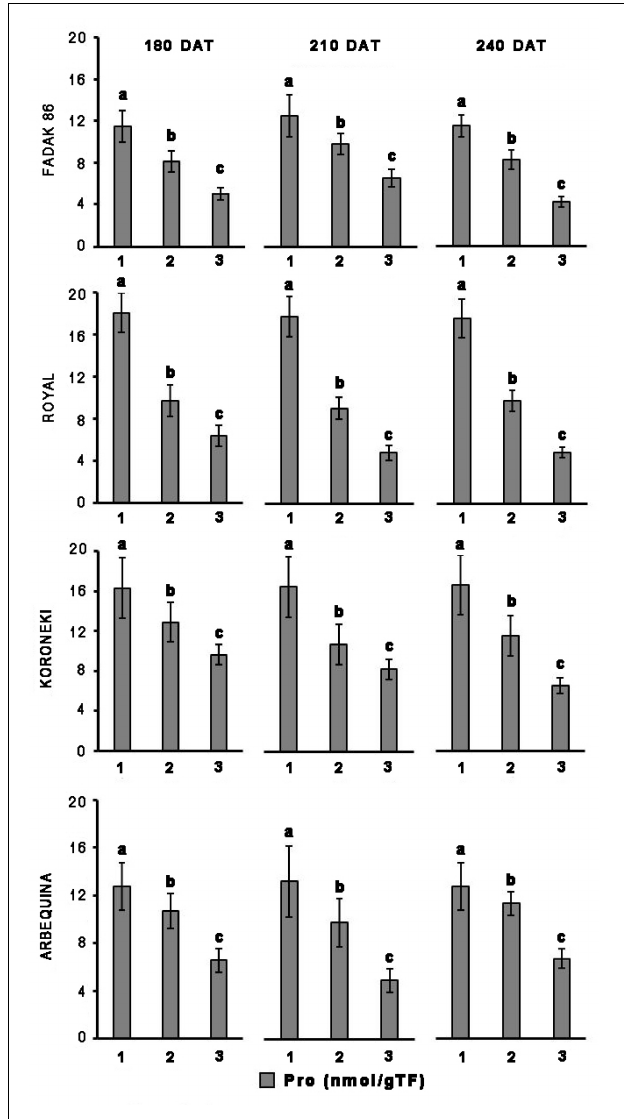
FIGURE 2 | Proline levels in leaves of four olive cultivars under saline stress. (1) control, (2) 100 mM NaCl, and (3) 200 mM NaCl. Each value represents the average of five experiments ± SEM. Mean values followed by different letters are significantly different ( P <